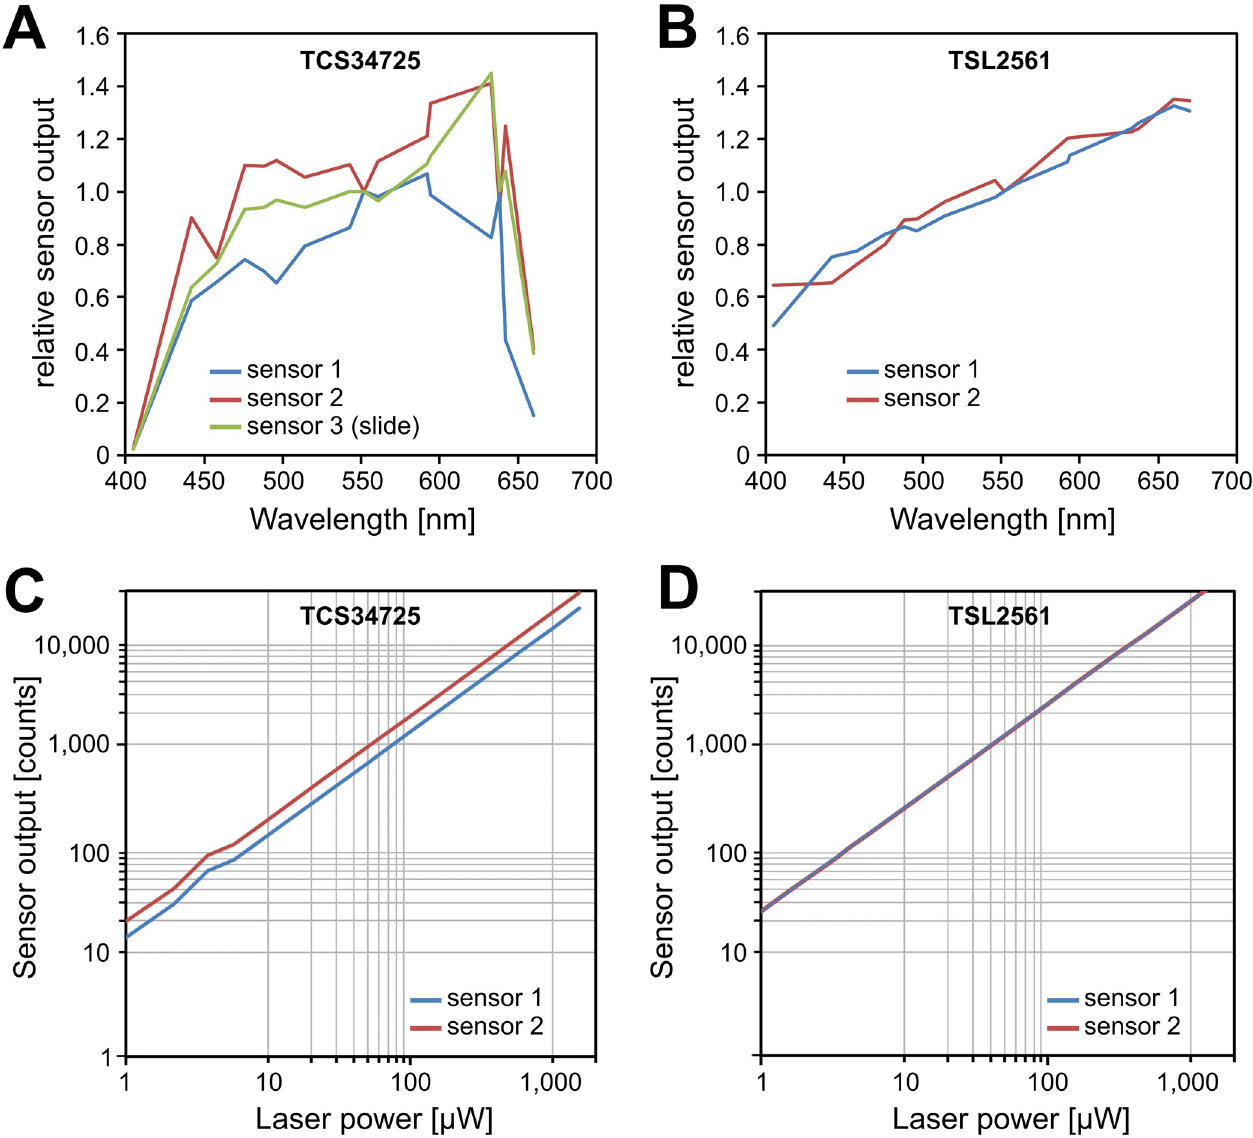
Fig 2. Comparing the spectral response and linearity of the different IntensityCheck light sensors. (A) Spectral response of three TCS34725 light sensors (two objective lens-shaped units mounted on objective turret, one slide sensor on the microscope stage) across the visible spectrum, with significant variation among the sensors. To compare the readings from the different sensors the output was calculated relative to the readings at 561nm. (B) Spectral response of two TSL2561 light sensors. (C) Measuring the linearity of the response of TCS34725 sensors 1 and 2 –same as in (A)—as a function of the actual laser power (0.2 to 1500 μ W 488nm). (D) Linearity of the responses from the two TSL2561 sensors, which are actually overlapping in this plot.